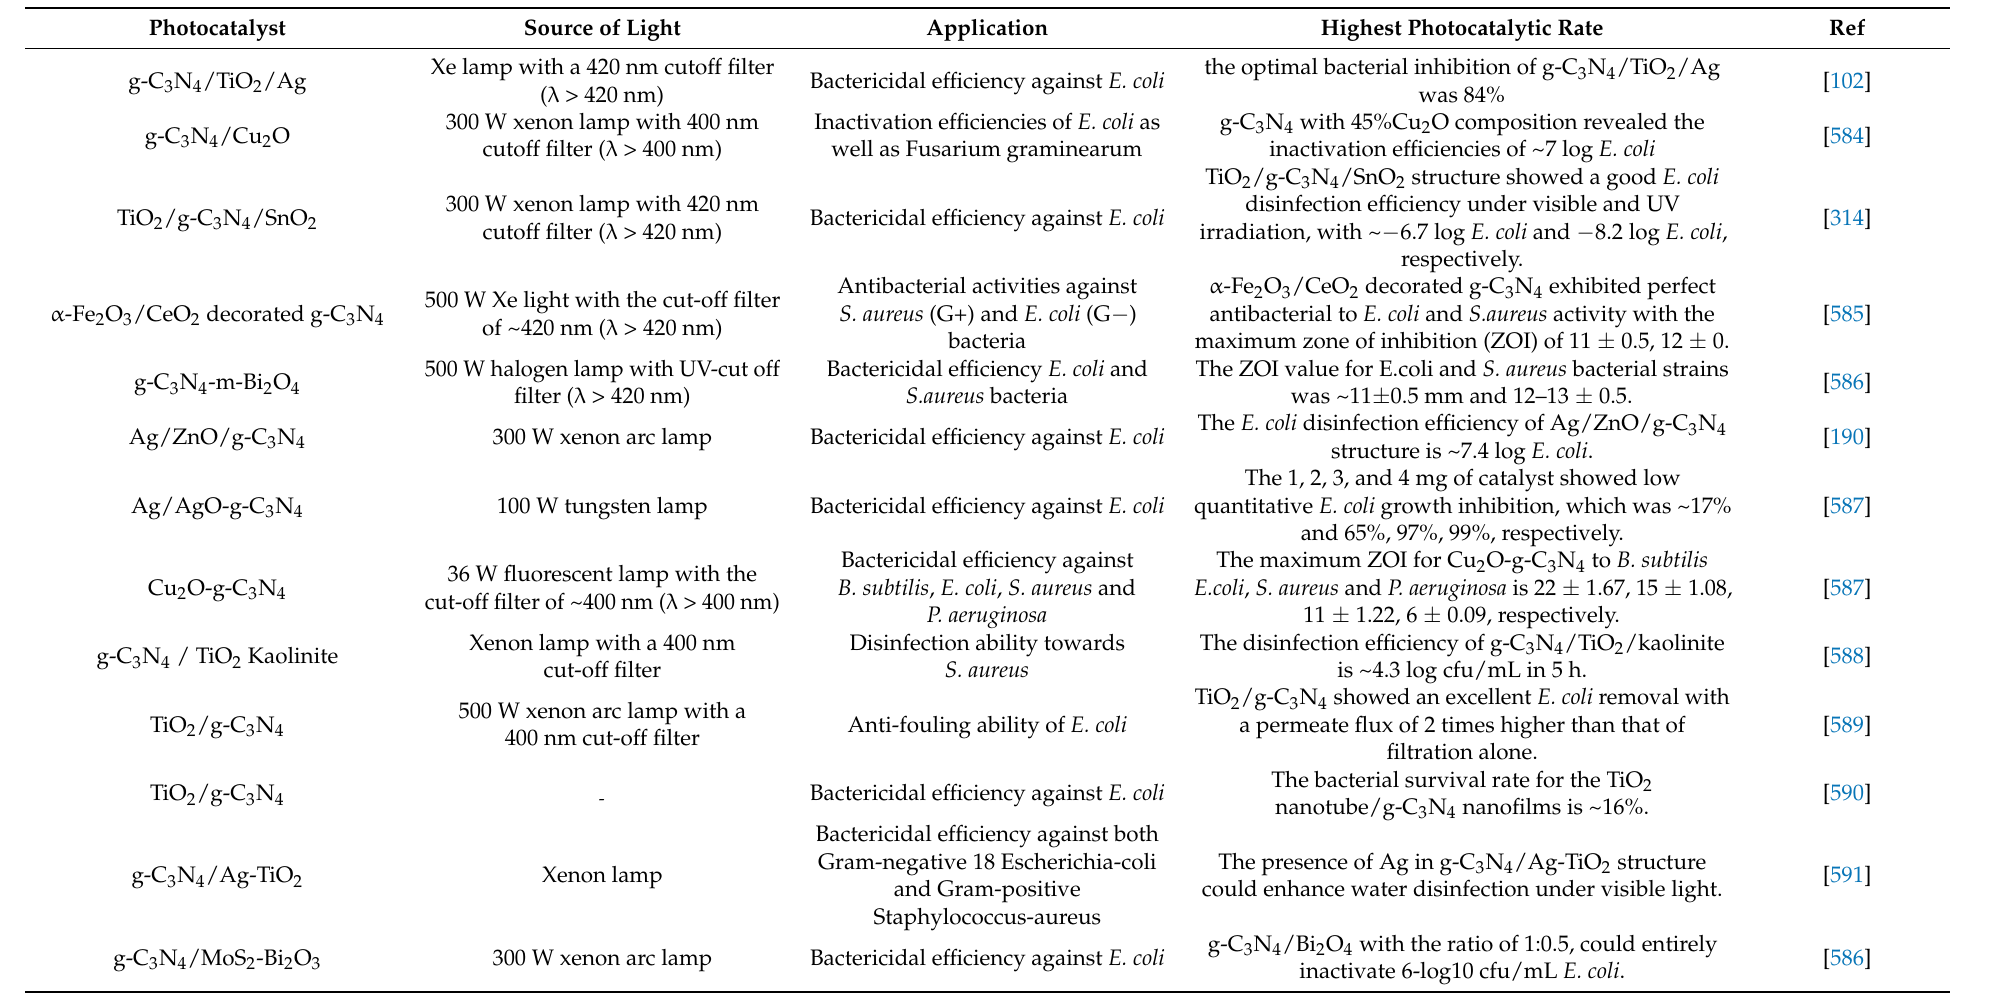
Table 6. Number of researches on the disinfection ability of the g-C 3 N 4 metal oxide-based